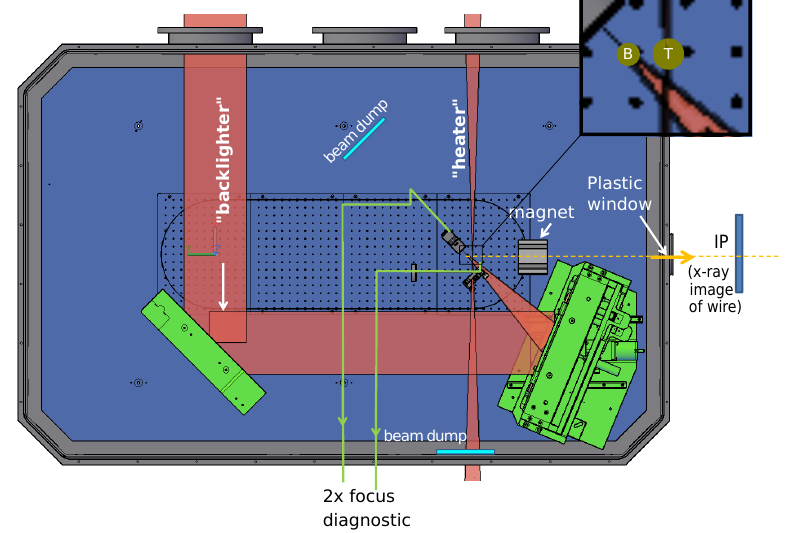
Figure 1. Measurement setup at Gesellschaft für Schwerionenforschung (GSI). The laser beam is split into backlighter and heater. The backlighter is shot at a tungsten wire for generating X-rays. The heater can optionally be shot at an object for generating shock waves or explosions. The inset shows a zoom-in on the tungsten backlighter wire (B) and the titanium wire (T) positions, depicted as green circles. In the presented measurement the heater is not shot at the titanium wire and the cold titanium wire is imaged. The images are obtained with imaging plates. The magnet is used to divert electrons, which occur due to the explosion of the wire and cause noise in the acquired